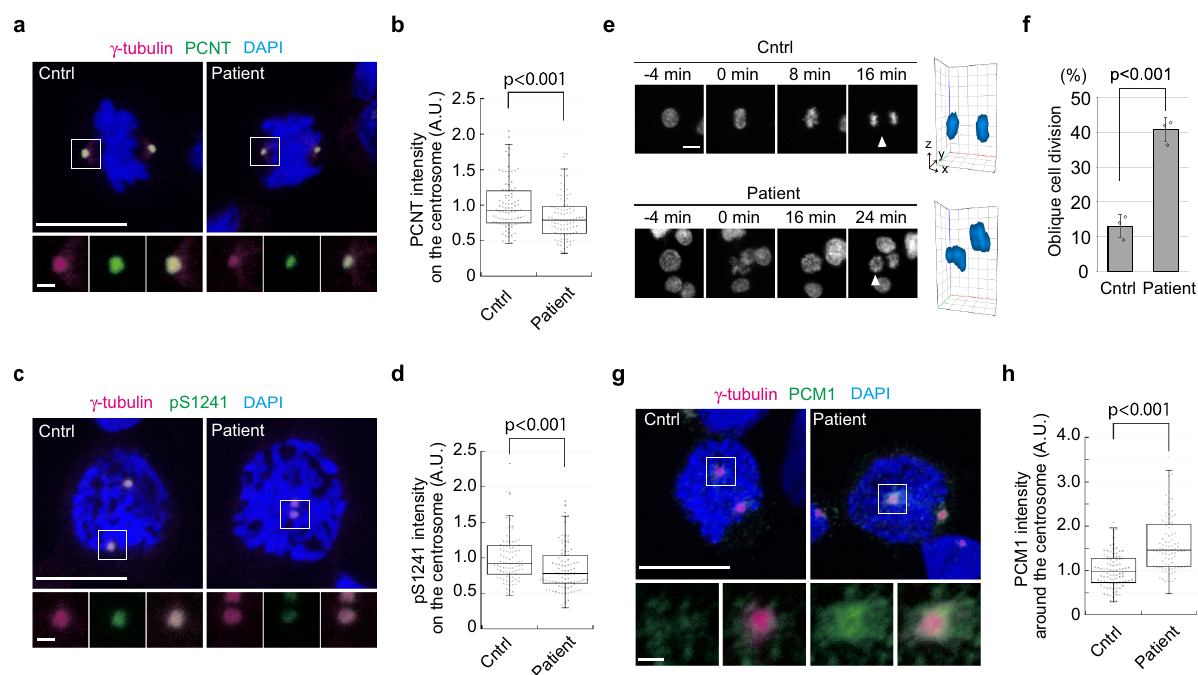
Fig. 8 LCLs from a microcephalic patient with CENP-E mutations show PCM defects and oblique divisions. a , b Control (Cntrl) and patient LCLs were synchronized with 2 mM thymidine for 22 h, and released for 5 h. Representative images for metaphase cells co-immunostained with antibodies against γ - tubulin (magenta) and PCNT (green) are shown ( a , scale bar = 10 μ m). The area enclosed by the square in each image is magni fi ed and shown under the panel (scale bar = 1 μ m). Relative PCNT intensities on the centrosome in metaphase cells were plotted in b ( N = 90, three independent experiments; whisker: 95% con fi dence interval; box: interquartile; center line: median). c , d Representative images for prophase LCLs co-immunostained with antibodies against γ -tubulin (magenta) and PCNT-pS1241 (green; c , scale bar = 10 μ m). The area enclosed by the square in each image is magni fi ed and shown under the panel (scale bar = 1 μ m). Relative PCNT-pS1241 intensities on the centrosome in prophase cells were plotted in d ( N = 90, three independent experiments; whisker: 95% con fi dence interval; box: interquartile; center line: median). e Live-cell imaging of control (Cntrl) and patient LCLs. DNA was visualized with Hoechst 33342. Representative time-course images of control (top) or patient (bottom) LCLs are shown (scale bar = 10 μ m). 3D reconstructions in the last time points (viewed from arrowheads) are also shown next to the images. f Percentages of oblique cell divisions observed in the live-cell imaging (see Methods section for de fi nition) were compared in the bar graph (>100 cells in total from three independent experiments; error bars: SD). g , h Representative images for prophase LCLs co-immunostained with antibodies against γ -tubulin (magenta) and PCM1 (green; g , scale bar = 10 μ m). The area enclosed by the square in each image is magni fi ed and shown under the panel (scale bar = 1 μ m). Relative PCM1 intensities around the centrosome in prophase cells were plotted in h ( N = 90, three independent experiments; whisker: 95% con fi dence interval; box: interquartile; center line: median). p -values were calculated by Mann – Whitney U tests ( b , d , h ) or an unpaired t -test ( f